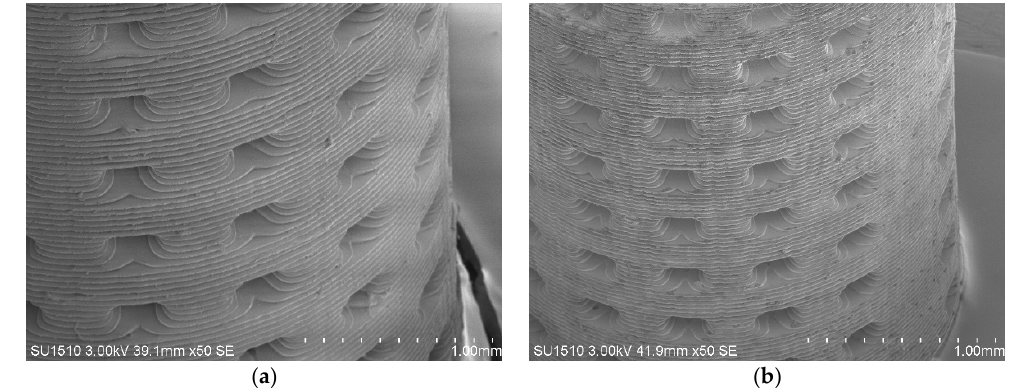
Figure 8. The fabricated parts derived from IDA-TMPTA suspension loaded with 33 vol.% of 3YSZ: ( a ) green body; ( b ) ceramic. ( a ) green body; ( b )